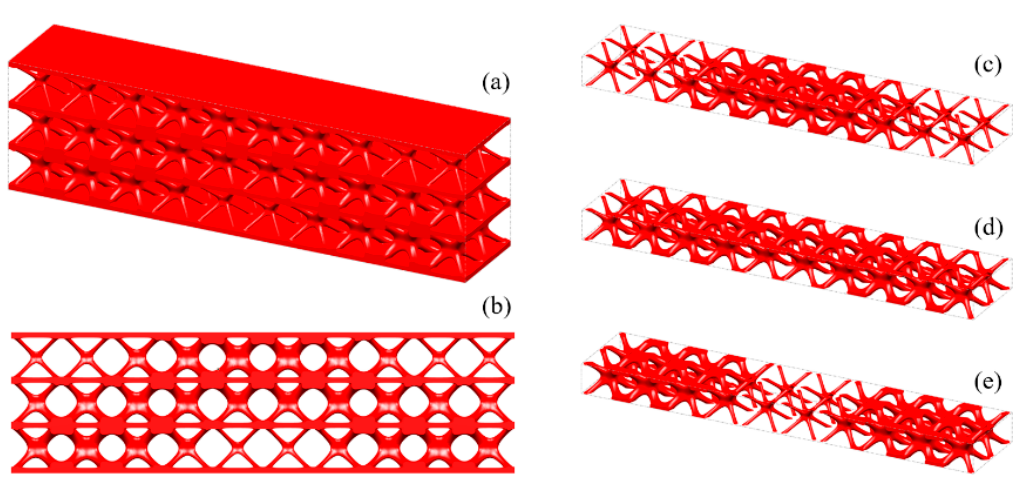
Figure 19. Optimized GLSS using the HLSM. ( a ) Optimized GLSS. ( b ) Front view of GLSS. ( c ) First core layer of GLSS. ( d ) Second core layer of GLSS. ( e ) Third core layer of GLSS.